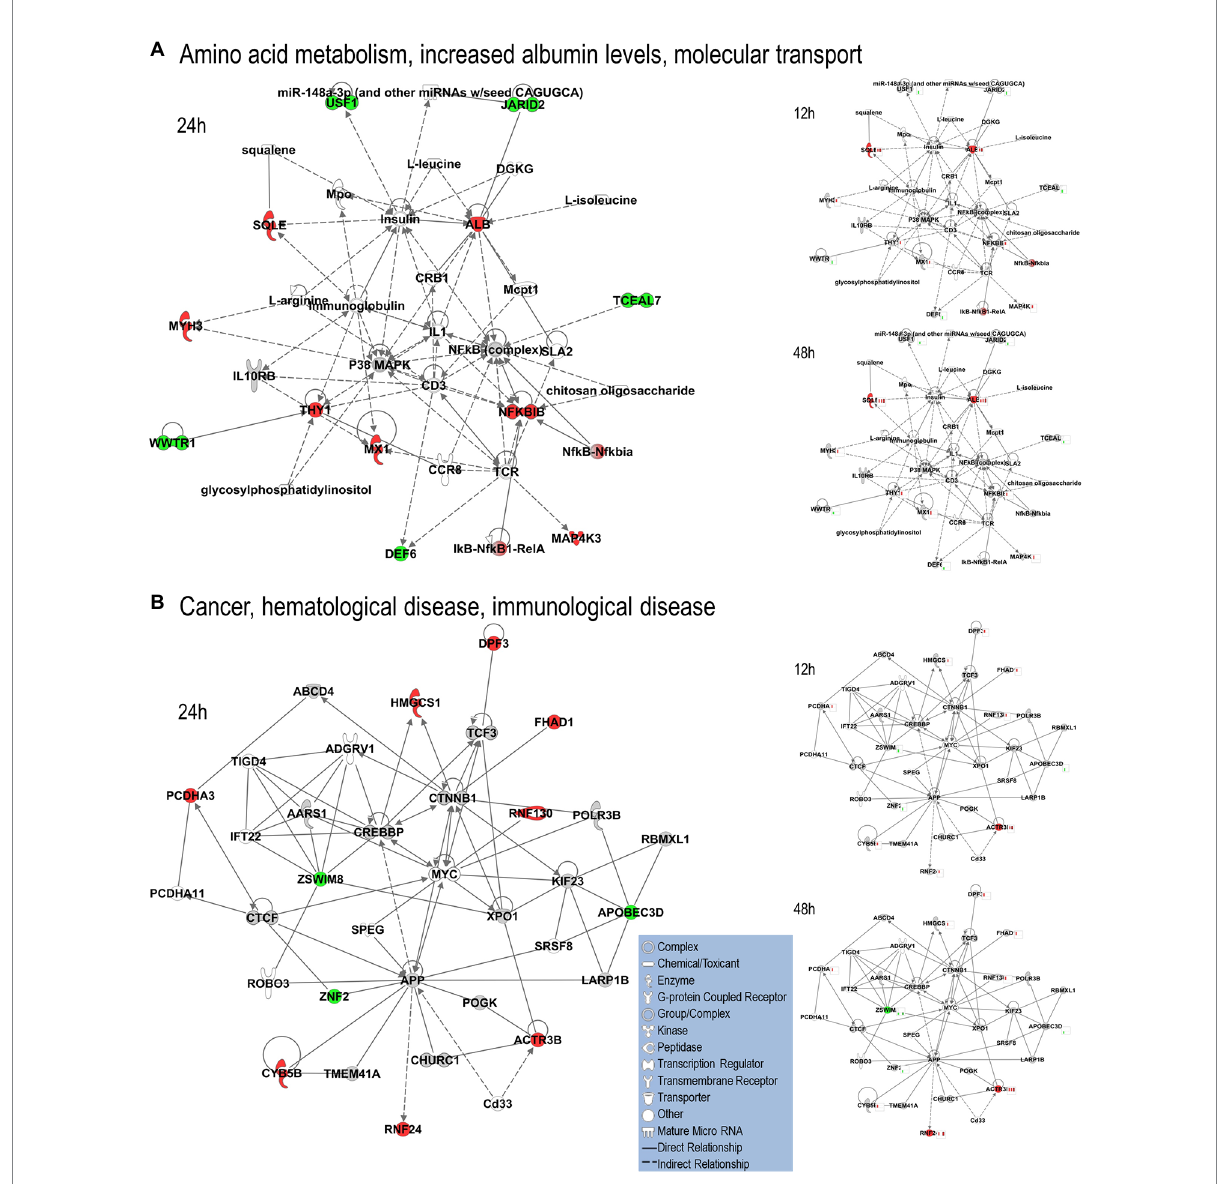
FIGURE 3 Top MRC-5 pathways affected by OC43 infection at 24 hpi. Proteins and their levels of dysregulation were uploaded into Ingenuity Pathway Analysis (IPA) and top pathways constructed. (A) The “amino acid metabolism, increased albumin levels, and molecular transport” network. (B) The “cancer, hematological disease and immunological disease” network. Protein levels at 12 and 48 hpi were overlaid onto these pathways (smaller diagrams at right). Upregulated proteins depicted in red, downregulated in green, insignificantly regulated in gray, direct interactions shown with solid lines and indirect interactions depicted with dashed lines. Molecular types as indicated in